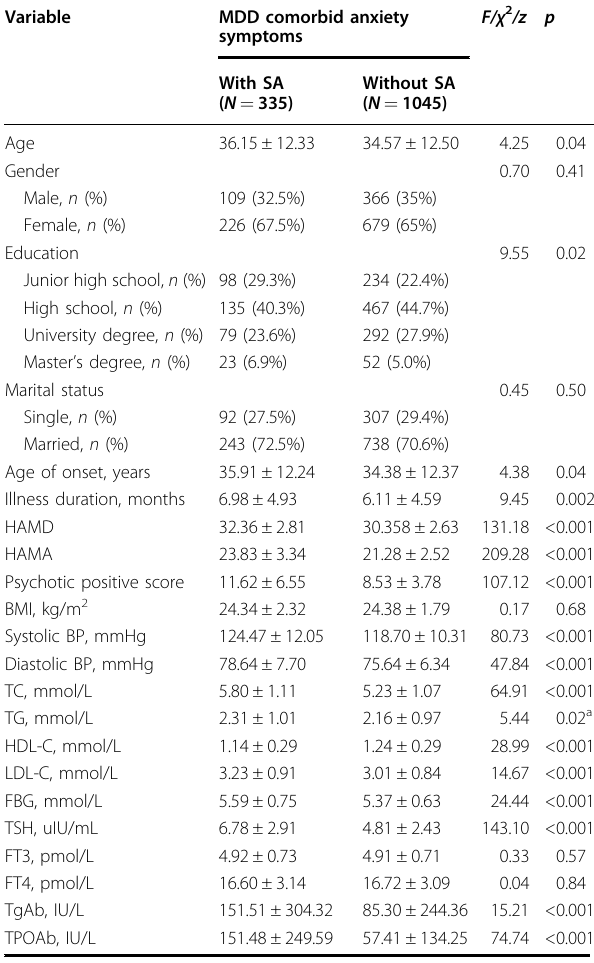
Table 1 Socio-demographics and clinical characteristics between MDD comorbid anxiety symptoms with suicide attempts and without suicide